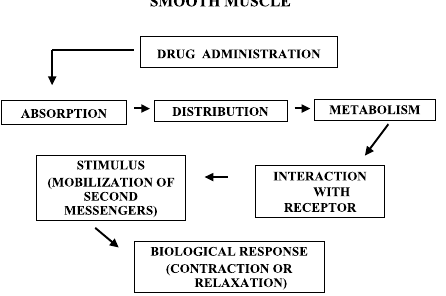
Fig. 1 – The receptor system cascade in smooth muscle, modified from Ariens